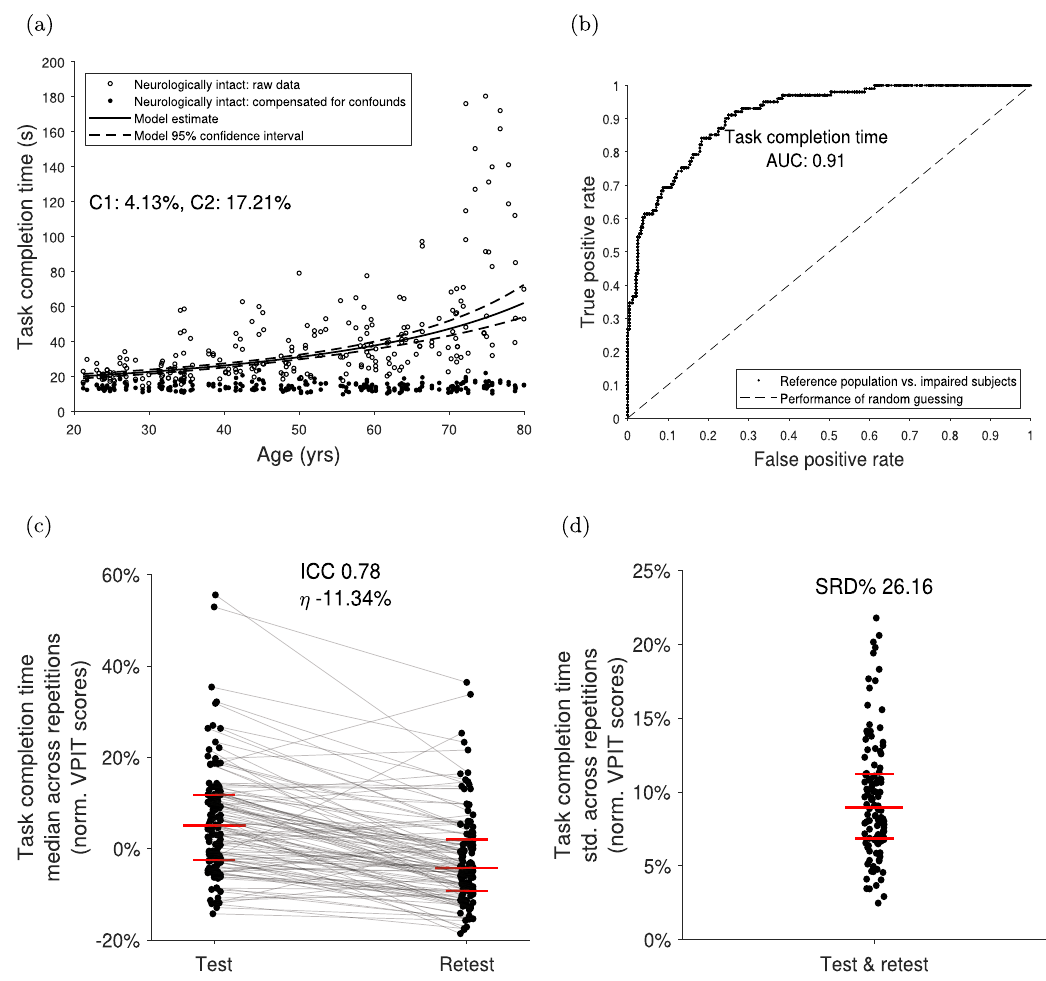
Fig. 2 Data-driven selection and validation of metrics: example of task completion time. a The in fl uence of age, sex, tested body side, handedness, and stereo vision de fi cits on each digital health metrics was removed using data from neurologically intact subjects and mixed effect models (model quality criteria C 1 and C 2). Models were fi tted in a Box – Cox-transformed space and back-transformed for visualization. Metrics with low model quality ( C 1 > 15% or C 2 > 25%) were removed. b The ability of a metric to discriminate between neurologically intact and affected subjects (discriminant validity) was evaluated using the area under the curve value (AUC). Metrics with AUC < 0.7 were removed. c Test – retest reliability was evaluated using the intra-class correlation coef fi cient (ICC) indicating the ability of a metric to discriminate between subjects across testing days. Metrics with ICC < 0.7 were removed. Additionally, metrics with strong learning effects ( η > − 6.35) were removed. The long horizontal red line indicates the median, whereas the short ones represent the 25th and 75th percentile. d Measurement error was de fi ned using the smallest real difference (SRD%), indicating a range of values for that the assessment cannot discriminate between measurement error and physiological changes. The distribution of the intra-subject variability was visualized, as it strongly in fl uences the SRD. Metrics with SRD% > 30.3 were